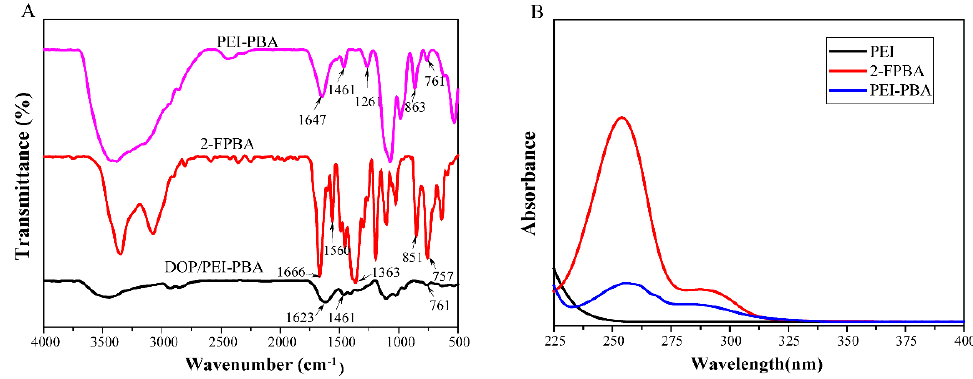
Figure 1. Schematic illustration of DOP/PEI-PBA hydrogel for delivery of insulin to protect against high-glucose-induced injury in HL-7702 cells.